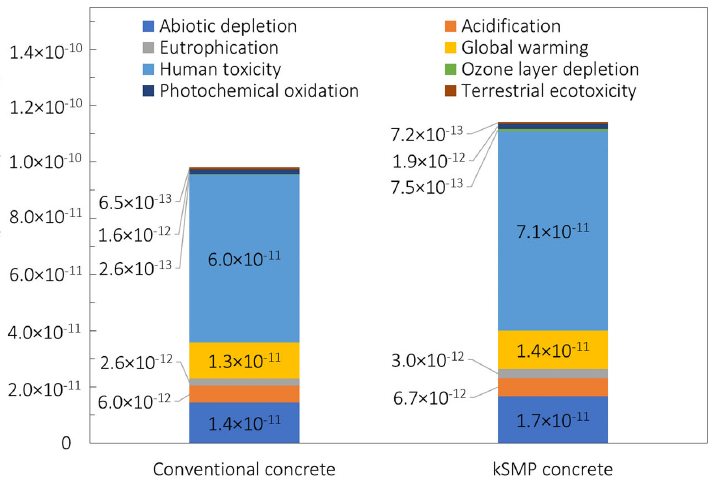
Figure 11. Comparison of LCIA results of the conventional concrete and kSMP concrete (normali